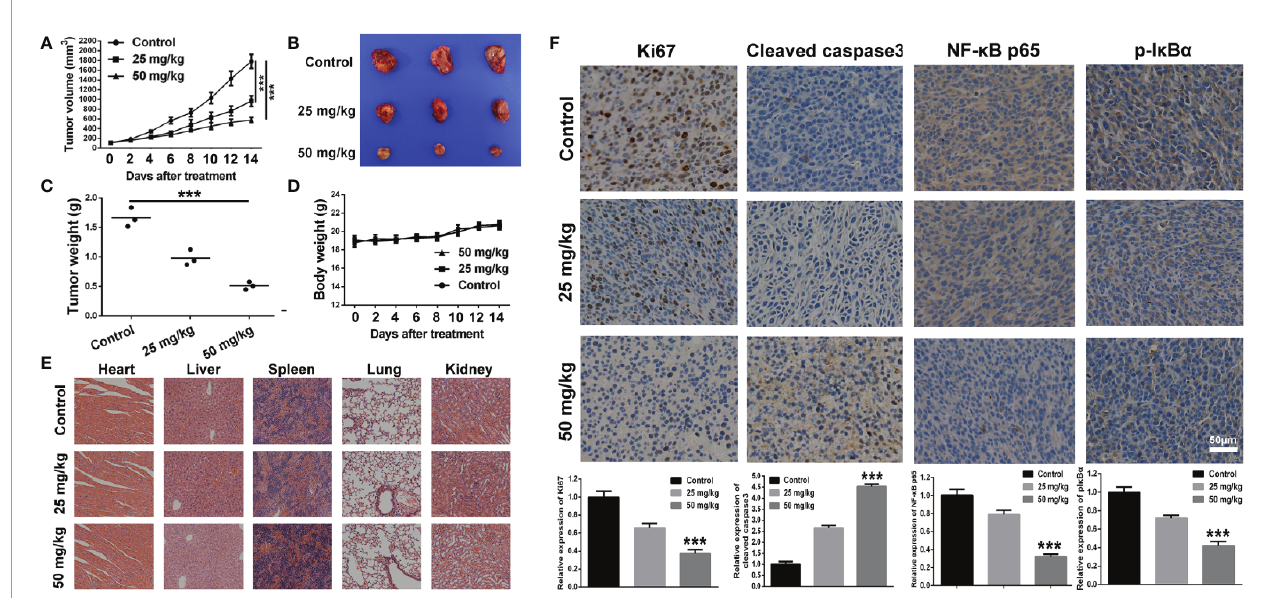
FIGURE 5 | BA suppressed 4T1 tumor growth by inhibiting NF- k B signaling pathway. 1×10 6 4T1 cells which was suspended in 100 m l of serum-free cell culture medium were injected into right fl ank of female Balb/c mouse to establish tumor mouse model. When the tumor volume reached about 100 mm 3 , the tumor-bearing mice were intraperitoneally administrated with vehicle, 25 mg/kg, or 50 mg/kg of BA every 2 days. (A) Curve of tumor growth during the process of experiment. (B) Tumor images of different treated groups at the termination of animal experiment in the tumor mouse model of 4T1 cells. (C) Tumor weight of different treated groups at the termination of animal experiment in the tumor mouse model of 4T1 cells. (D) Body weight of mice of different treated groups during the process of experiment. (E) Pathological analysis of major organs of subcutaneous tumor-bearing mice after treatment of different doses of baicalin. (F) Immunohistochemical analysis of Ki67, Cleaved caspase3, NF- k B p65, and p-I k B a of tumor sections of different treated groups. Signi fi cant differences are indicated as follows: *** P <